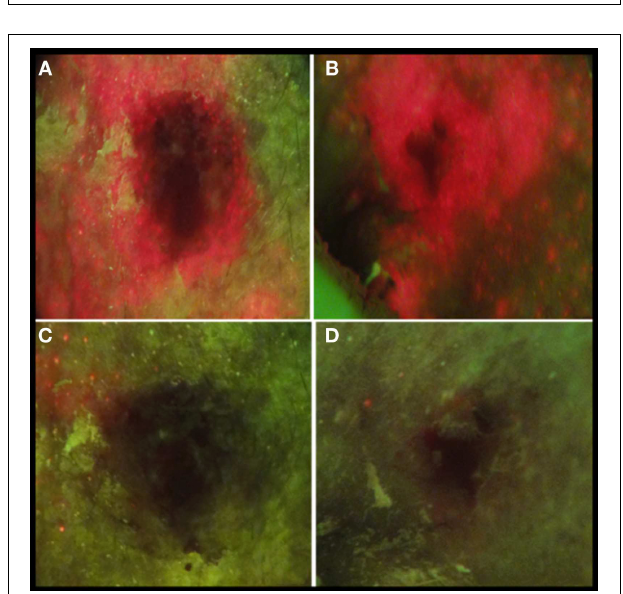
FIGURE 5 | PpIX fluorescence images for comparison of PPIX formation (A,C—before PDT) and degradation (B,D—after PDT) in different lesions of the same patient in second session of